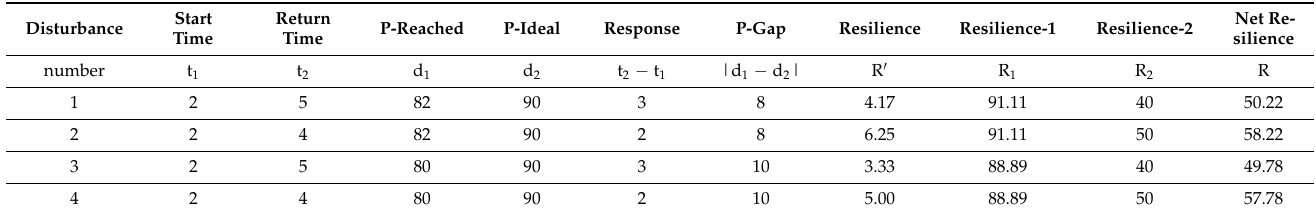
Table 3. Illustrative example of resiliency